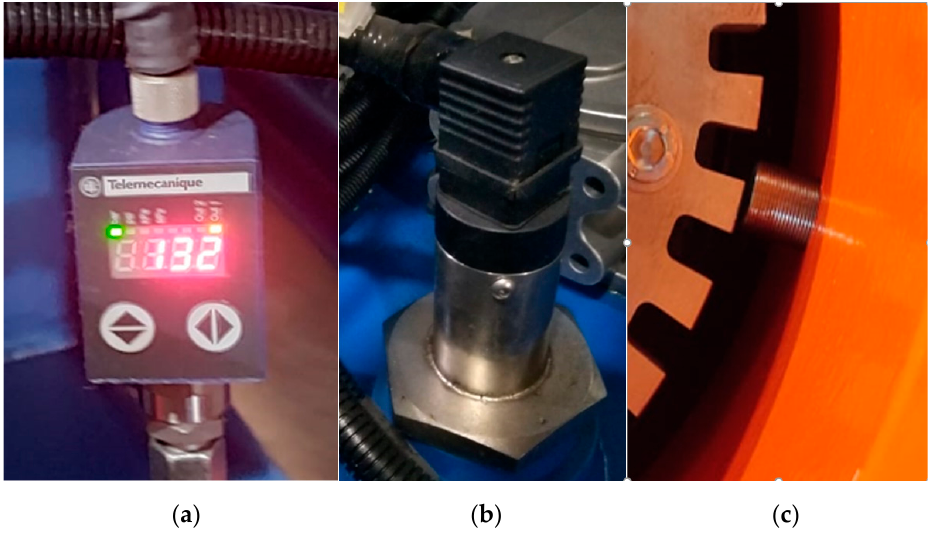
Figure 14. Some of the measuring points, oil pressure ( a ), oil level ( b ), turbine speed ( c ). The data to be used as a training dataset, which includes different working condi- tions recorded at different times with a one-second sampling period, are shown in the graph given in Figure 15. While creating this data group, data from various operating conditions were included in the group so that the model could show high performance in different operating conditions. Since the amount of movement(mm) per second and ap- plied forces on the guide vanes change in different operating conditions, a comprehensive data group was formed by taking data from the start sequence, stop sequence, long-term stop and long-term loaded running conditions of the unit. As a result, a set consisting of 10,529 points was obtained. The main focus while creating the dataset was not the number of points but the inclusivity of different conditions. For example, in order to include the effect of oil temperature, data at different times in the range of 20–34 degrees were included in the training group. As seen in the graph, the behavior of the pressure during the rise and fall may vary according to the operating conditions. It can be easily understood from the slope changes and breaks in the pressure curve that the pressure drops faster than normal as a result of opening the guide vanes through servomotors during the commissioning of the unit and moving it over the stationary state until it reaches the speed–power set